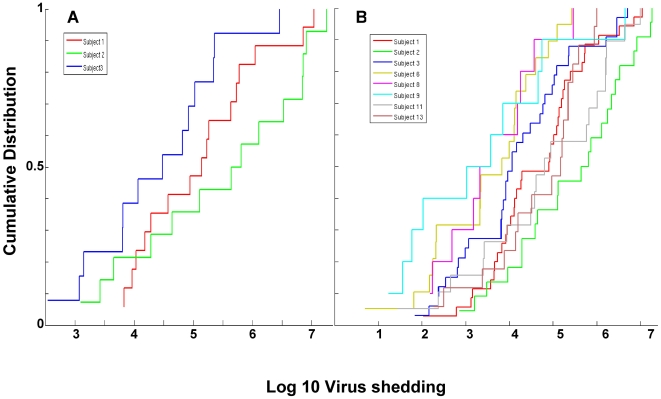
Cumulative distribution function (CDF) for the shedding data.(A) The log10 values for the shedding data in Figure 3 are plotted cumulatively from lowest to highest against the normalized number of data points. Each step up represents a data point. Thus the extreme left point on each graph represents the lowest value for which there is only one data point, the next step up represents the second lowest point and so on till the last most extreme right point represents the highest value and therefore includes, cumulatively, all of the data points. (B) Cumulative distribution function (CDF) for all the shedding data summarized in Figure 5A.